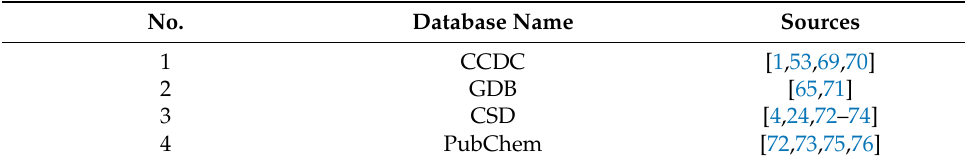
Table 1. The common databases in the pieces of